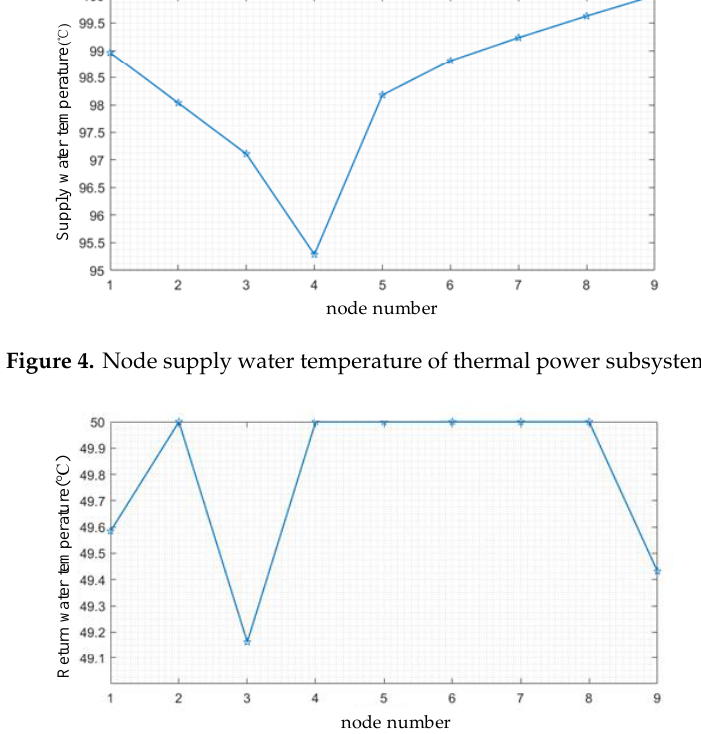
Figure 5. Node return water temperature of thermal power subsystem.